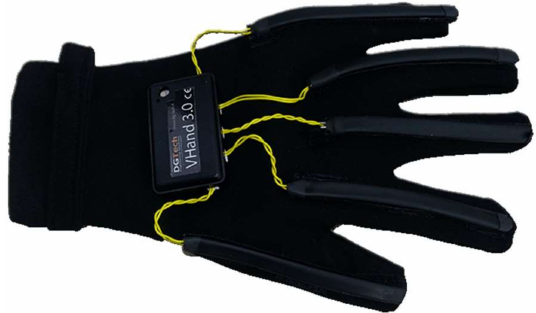
Figure 21. The A DG5-VHand glove equipped with five flex sensors and one 3-axis ACC